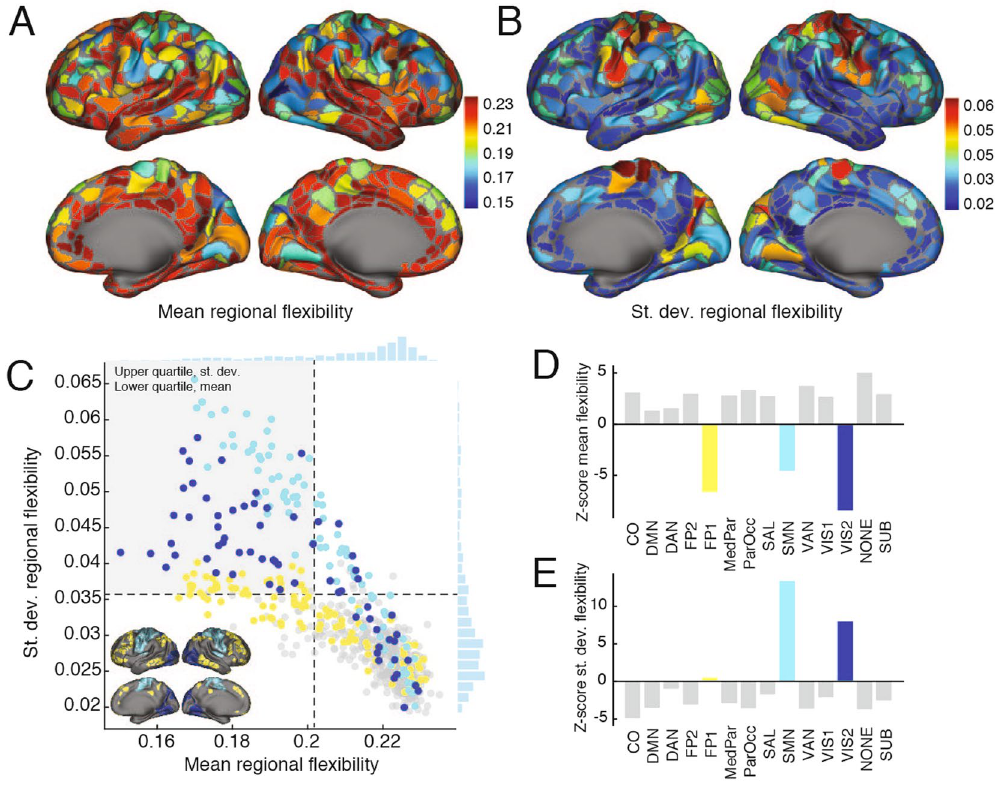
Figure 2. Summary of flexibility analysis. ( A , B ) Topographic representation of mean and standard deviation flexibility. ( C ) Mean and standard deviation of flexibility scores plotted against one another. Color-coding indicates brain systems: fronto-parietal (purple), somatomotor (green), peripheral visual (blue), and the rest of brain (grey). Inset depicts topographic representation of somatomotor (SMN), fronto-parietal (FP1), and peripheral visual (VIS2). ( D ) The z -score of the mean system flexibility. ( E ) The z -score of the standard deviation of system